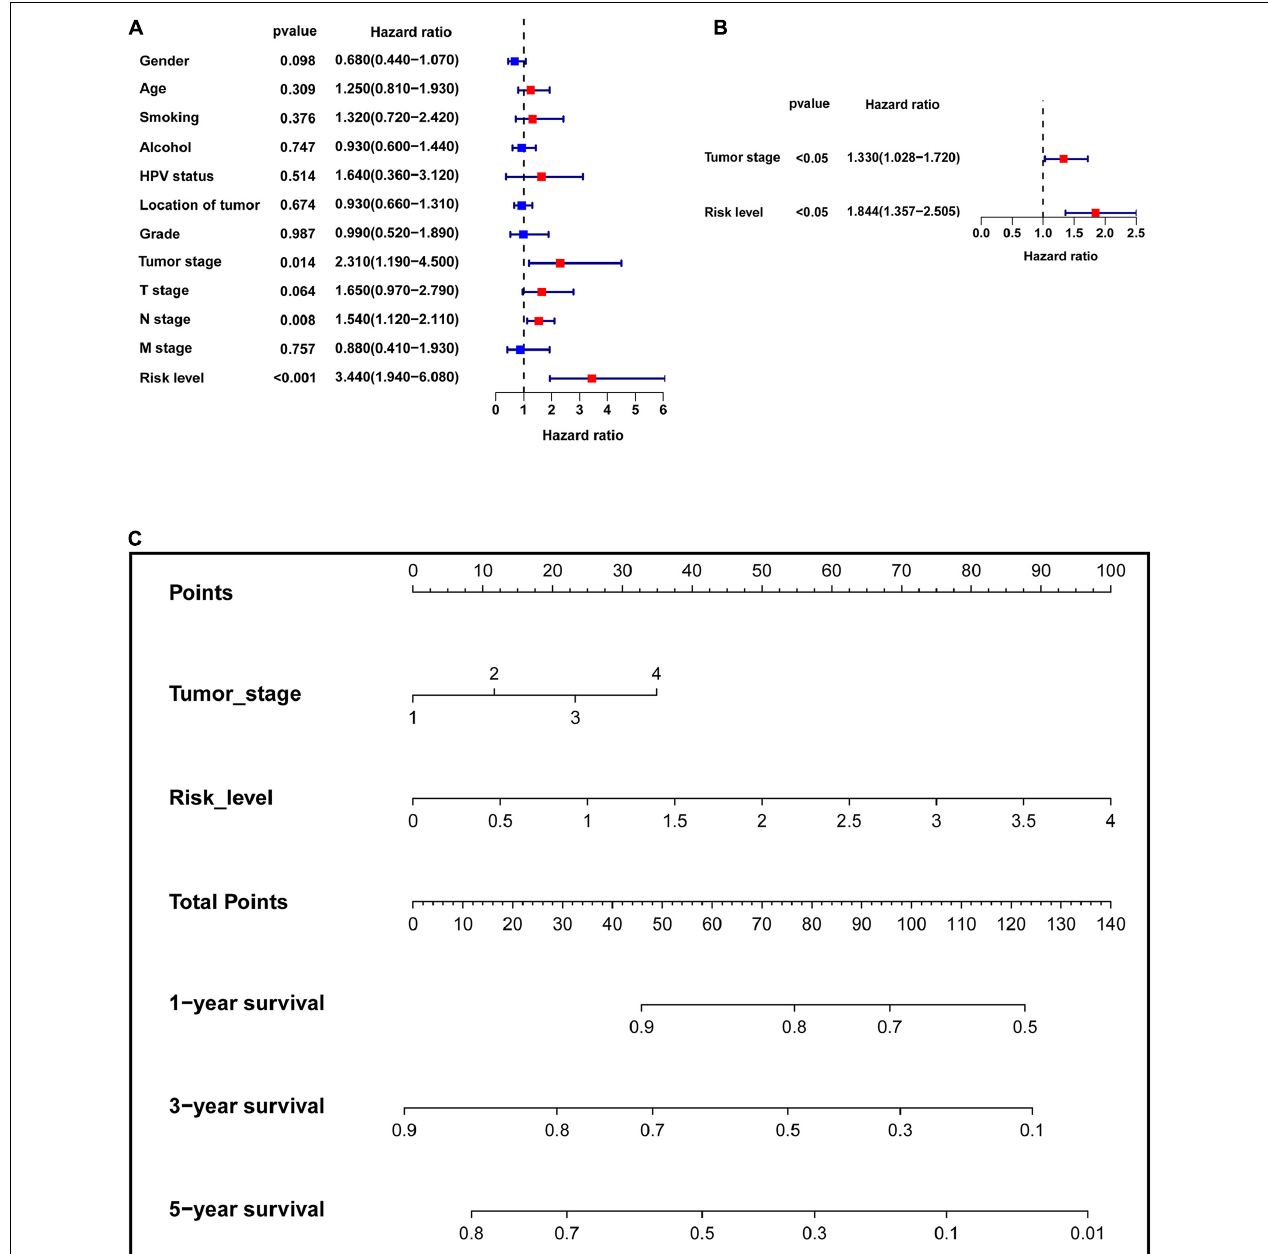
FIGURE 9 | Establishment of the multi-factor prognostic model. (A) Univariate Cox proportional hazards regression analysis was performed to assess which factors have significant prognostic value. (B) Multivariate Cox proportional hazards regression analysis was used to establish the multivariate prognostic model. (C) Nomogram was built to predict 1-, 3-, and 5-year survival